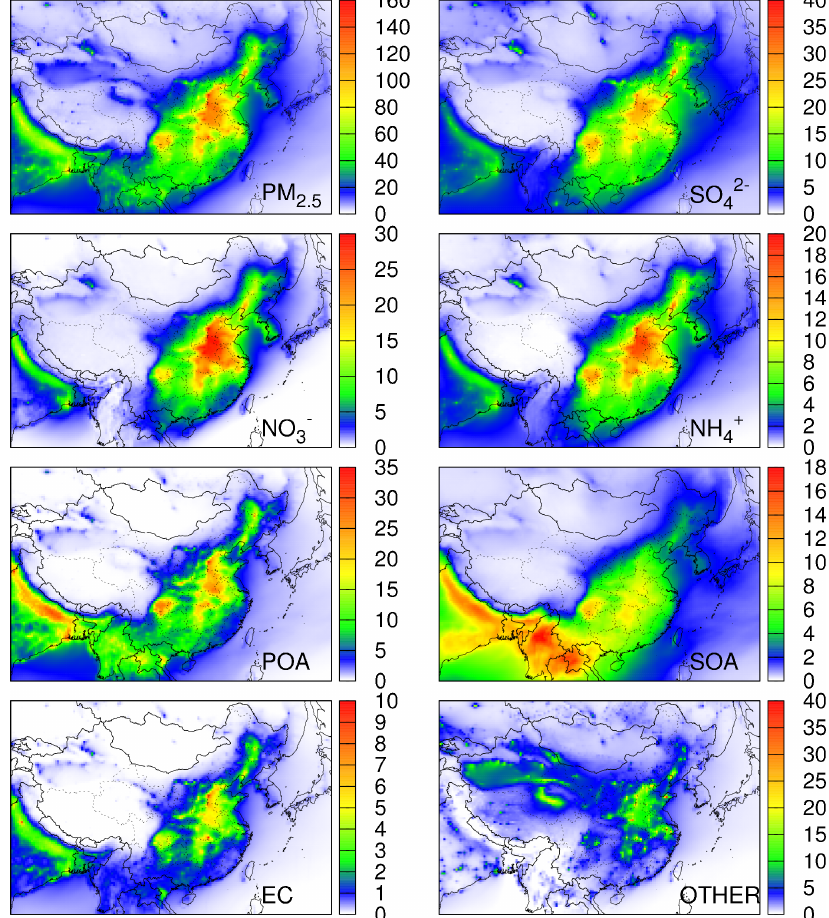
Figure 8. Spatial distributions of PM 2 . 5 and its components in the ensemble predictions. Units are µgm − 3 . The scales of the panels are different. White indicates zero, while blue, green, yellow, and red mean concentrations from low to high. “OTHER” represents the other implicit components